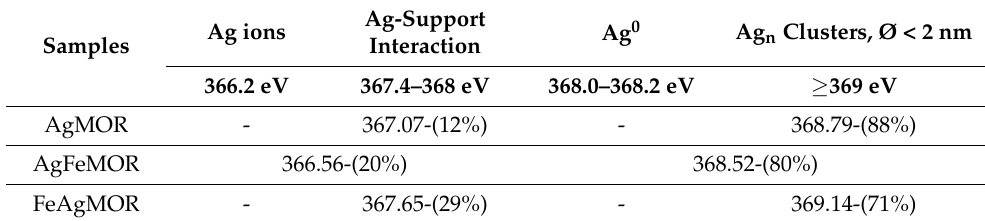
Table 3. Ag 3d 5/2 binding energy (eV) of deconvoluted